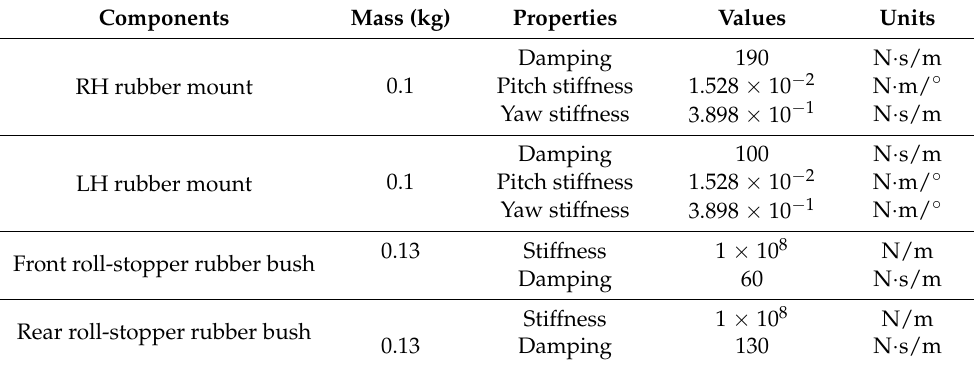
Table 1. Linear stiffness and damping properties of PT cradle rubber mounts and roll-stopper rubber